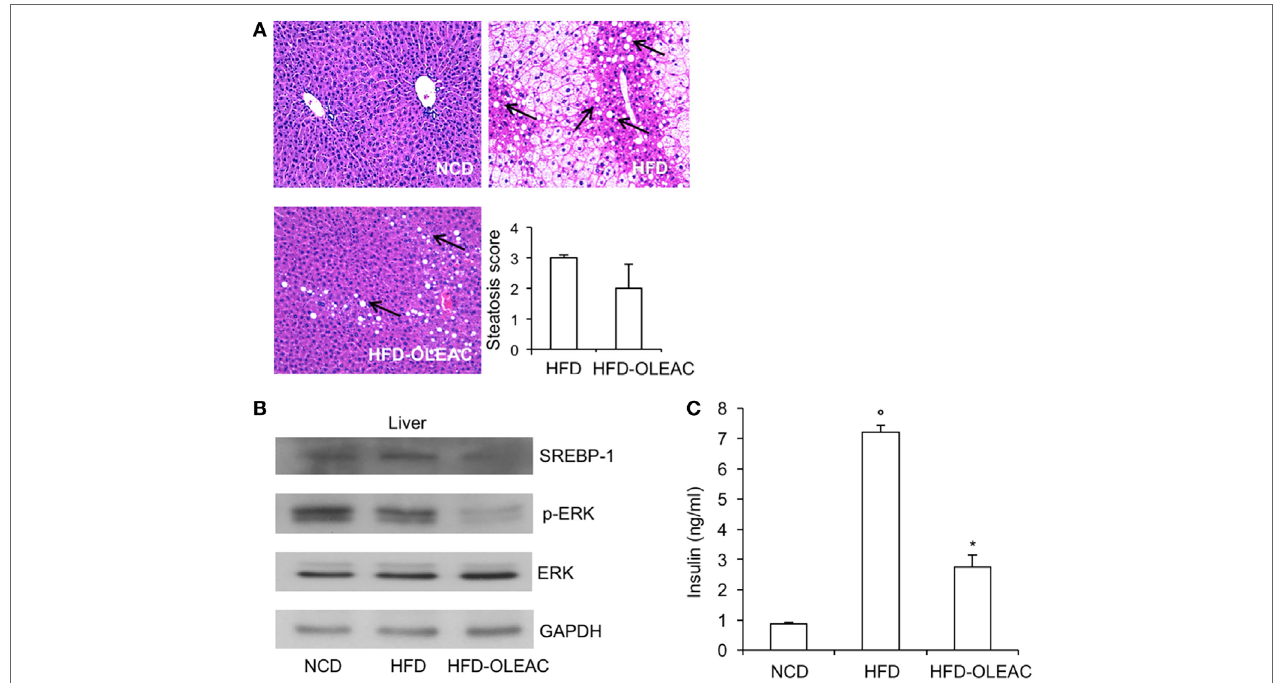
FigUre 8 | Effects of oleacein on insulin levels, liver steatosis, and Western blot analyses of SREBP-1 and ERK. (a) Hematoxylin and eosin staining of liver sections (20 × magnification). Liver of obese mice fed with high-fat diet (HFD) was rich in fat vacuoles (indicated by the arrows). For steatosis evaluation, a numerical score was assigned to each section, on the basis of the percentage of vacuolated cells as calculated for each mouse liver: 1 = 1–25%, 2 = 30–65%, 3 = > 70%. (B) Protein expression levels of SREBP-1, ERK, and p-ERK were detected in liver from oleacein-treated and untreated mice fed with HFD and mice fed with NCD. GAPDH, control of protein loading. (c) Blood samples were collected as indicated in the Section “Materials and Methods.” Insulin levels were measured after 13 weeks of feeding with HFD with and without oleacein. Values are expressed as mean ± SD. * p < 0.05 vs mice fed with HFD. ° p < 0.05 vs mice fed with